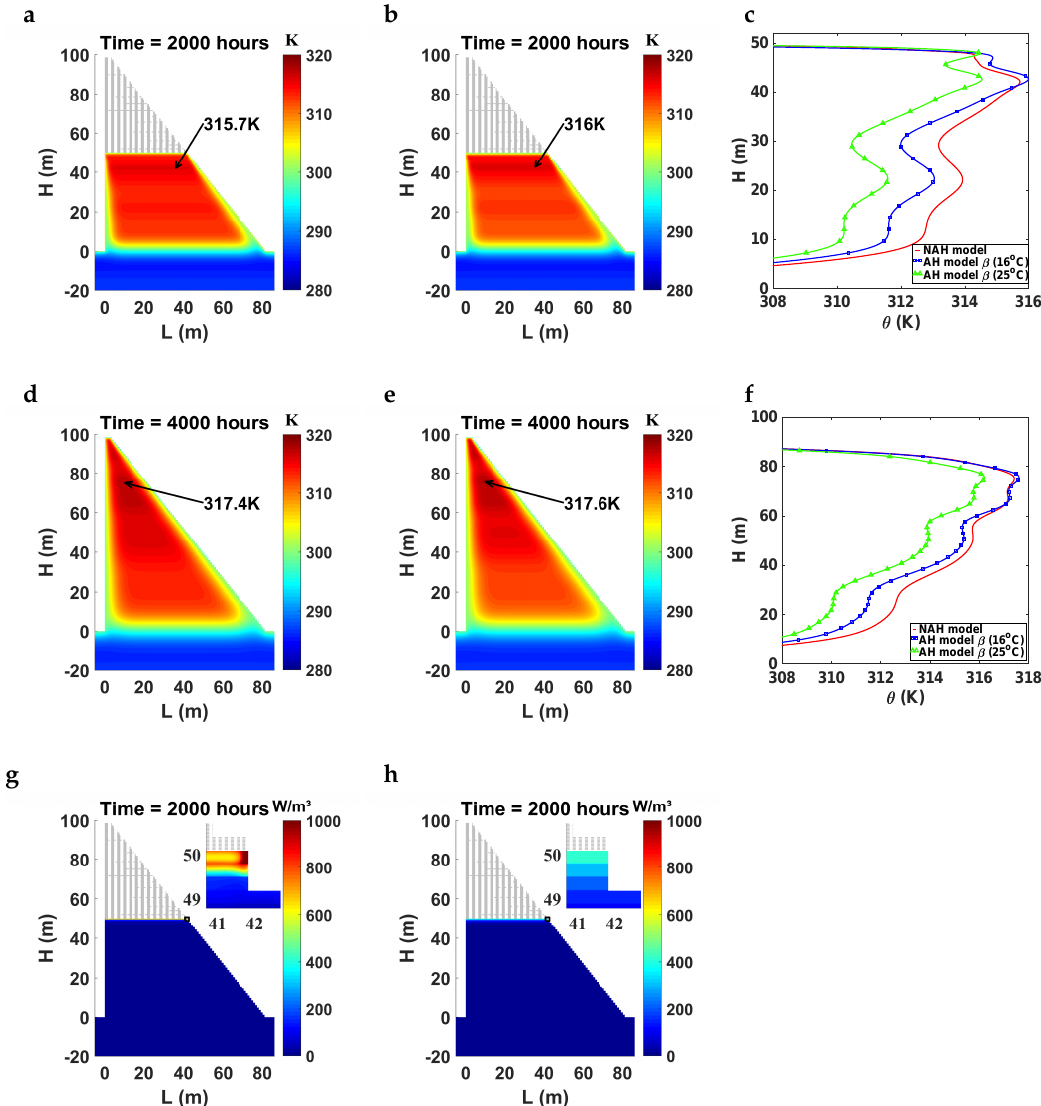
Figure 2. Influence of the hydration model on the temperature field. The construction of the dam begins on 1 April 2014, and lasts 165 days. We simulate the evolution of the temperature field using a NAH model, and two AH models with β -parameters equal to 7.69 × 10 − 6 s − 1 and 1.21 × 10 − 5 s − 1 , which correspond to placing temperatures of 16 ◦ C and 25 ◦ C respectively. We depict the temperature fields when the construction is at mid-height (50 m) ( a ) for the NAH model, and ( b ) for the AH model with β = 7.69 × 10 − 6 s − 1 . We compare the temperature fields in a vertical profile located 10 m from the upstream face for the three simulations ( c ). We repeat the three plots when the construction has finished in panels ( d )–( f ). The heat generation rate at mid-height time computed with the NAH model is included in the panel ( g ), and the AH model with β = 7.69 × 10 − 6 s − 1 is in panel ( h ). We also include a view of the last five lifts built in the